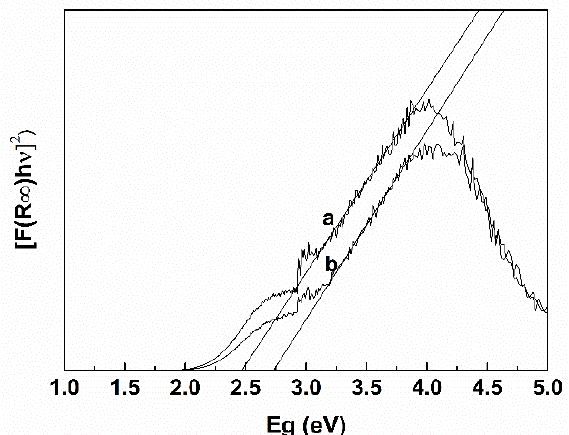
Figure 6. UV-vis spectra of catalysts with different supports. ( a ) 28V/HMS. ( b ) 28V/Ti-HMS (30). The Raman spectra of the samples in the region of 200 to 1200 cm − 1 are presented in Figure 7. The distinctive Raman characteristics of crystalline V 2 O 5 are the bands centered at 282, 301, 405, 478, 525, 700, and 995 cm − 1 , which appear for all samples [31] and thus agree well with the XRD results as shown in Figure 2 where well-resolved V 2 O 5 patterns are observed. It is notable that a new band at 1035 cm − 1 , which is identified as the terminal species (O=V(OSi) 3 ) [60], is only observed for the Ti-modified catalysts. This finding further